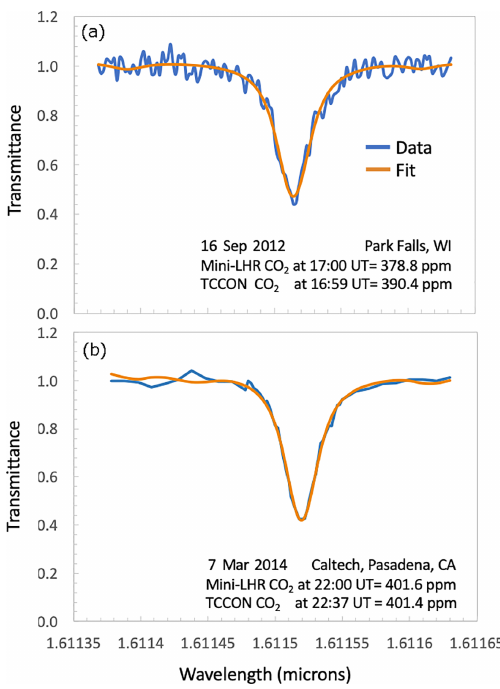
Figure 3. Side-by-side comparisons of mini-LHR and TCCON in- struments (a) at Park Falls on 16 September 2012 and (b) at Caltech on 7 March 2014. Mini-LHR data are shown in blue with the PSG retrieval fit in orange. The 2012 data are the average of three scans collected over the period of an hour, and the 2014 data are the aver- age of five scans collected over the period of a half hour. The result- ing XCO 2 value for the mini-LHR and the nearest corresponding value for TCCON are shown in the